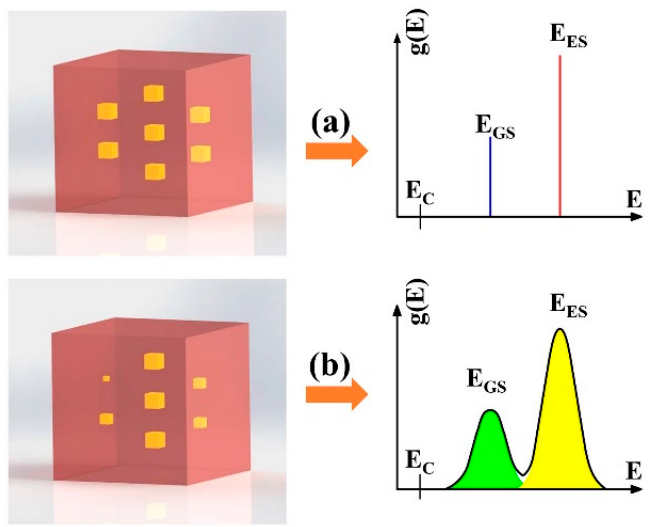
Figure 8. Energy state density of ( a ) ideal and ( b ) real QDs.